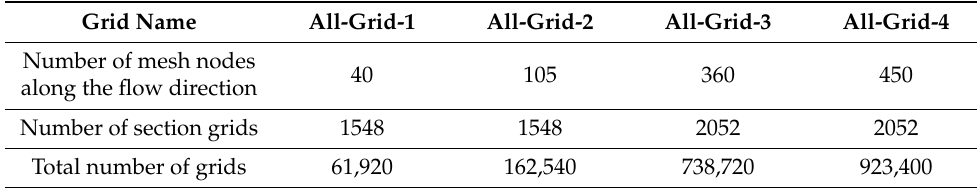
Table 3. Grid schemes of the total flow field computing